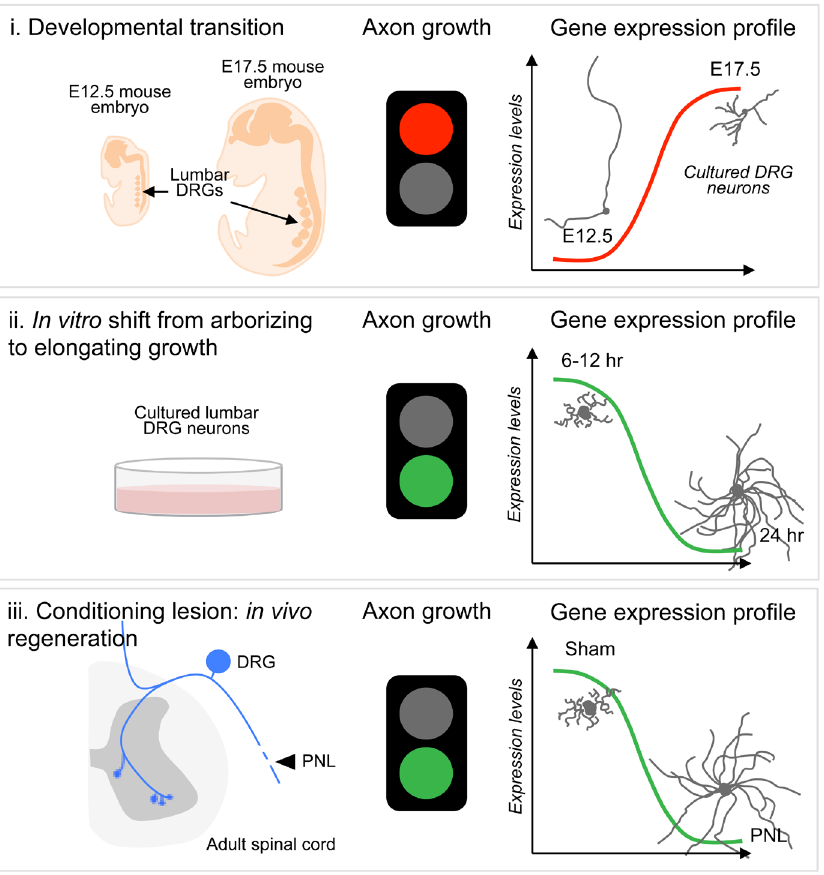
Figure 2. The transcriptional landscape of mouse dorsal root ganglia (DRG) neurons in both growth-competent and -incompetent states. DRG neurons have been instrumental in dissecting key molecular mechanisms of axon growth and regeneration failure. Whole transcriptome sequencing of DRG neurons from different stages of axon growth, including a developmental transition from axon growth to synapse formation, a shift from arborizing to elongating growth, and axon regeneration after a peripheral nerve lesion (PNL), has identified novel negative regulators of axon growth and regeneration, thus expanding the number of targets that could be manipulated for therapeutic gain. E, embryonic